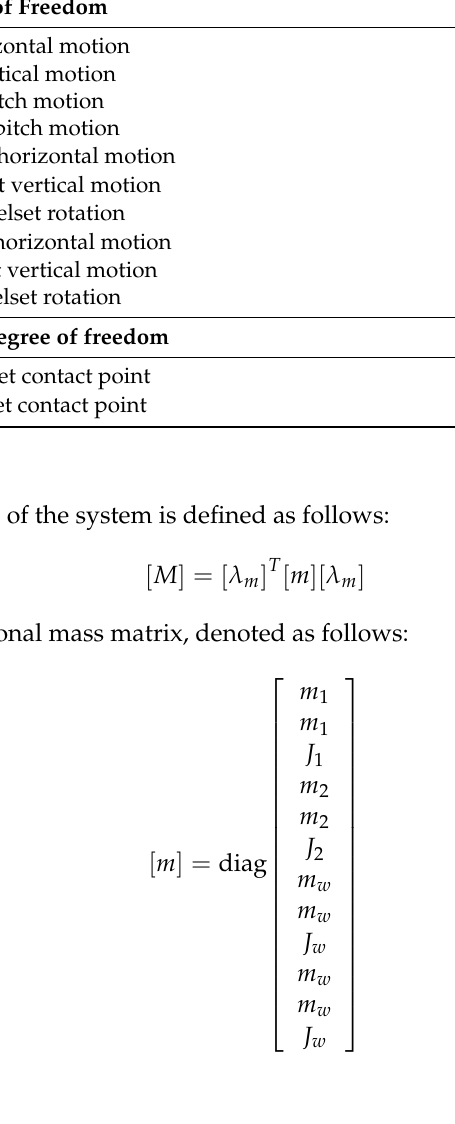
Table 1. Description of the degrees of freedom for the model. Degree of Freedom Symbol Bogie horizontal